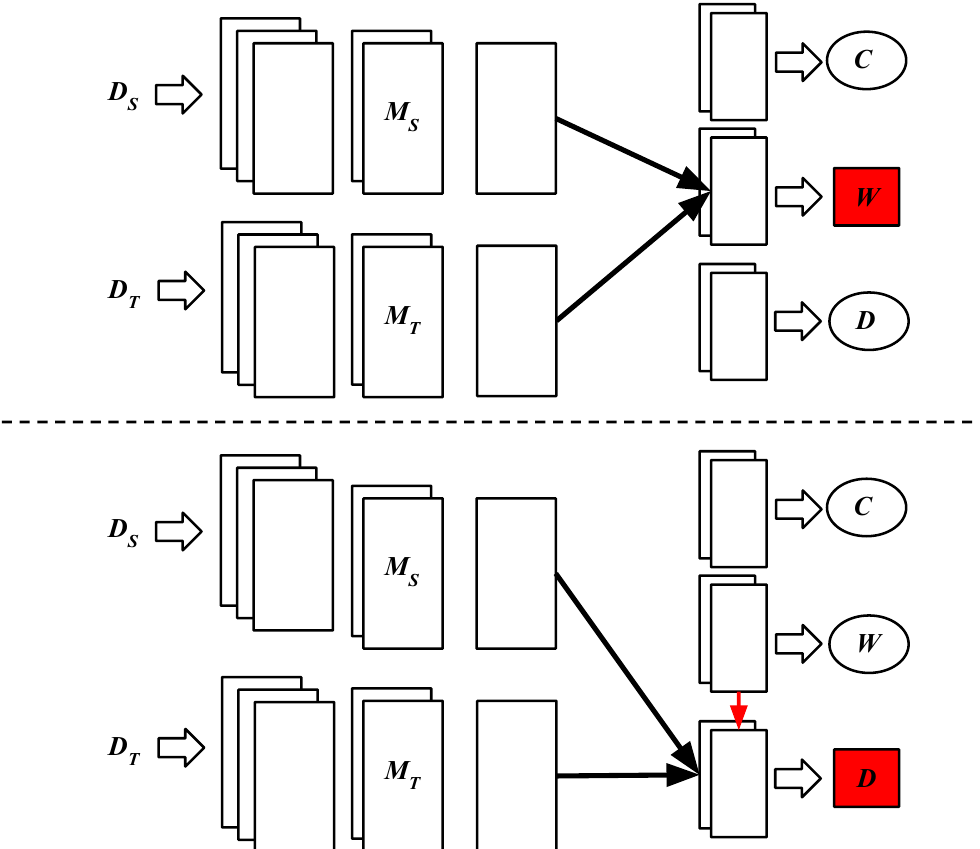
Figure 2. Illustration of the five neural networks involved in the DIWAN algorithm. On the top , the re-weighting network is trained from the source and target representer network representations of the source and target data, respectively. On the bottom , the domain discriminator is trained using the weights obtained from the re-weighting